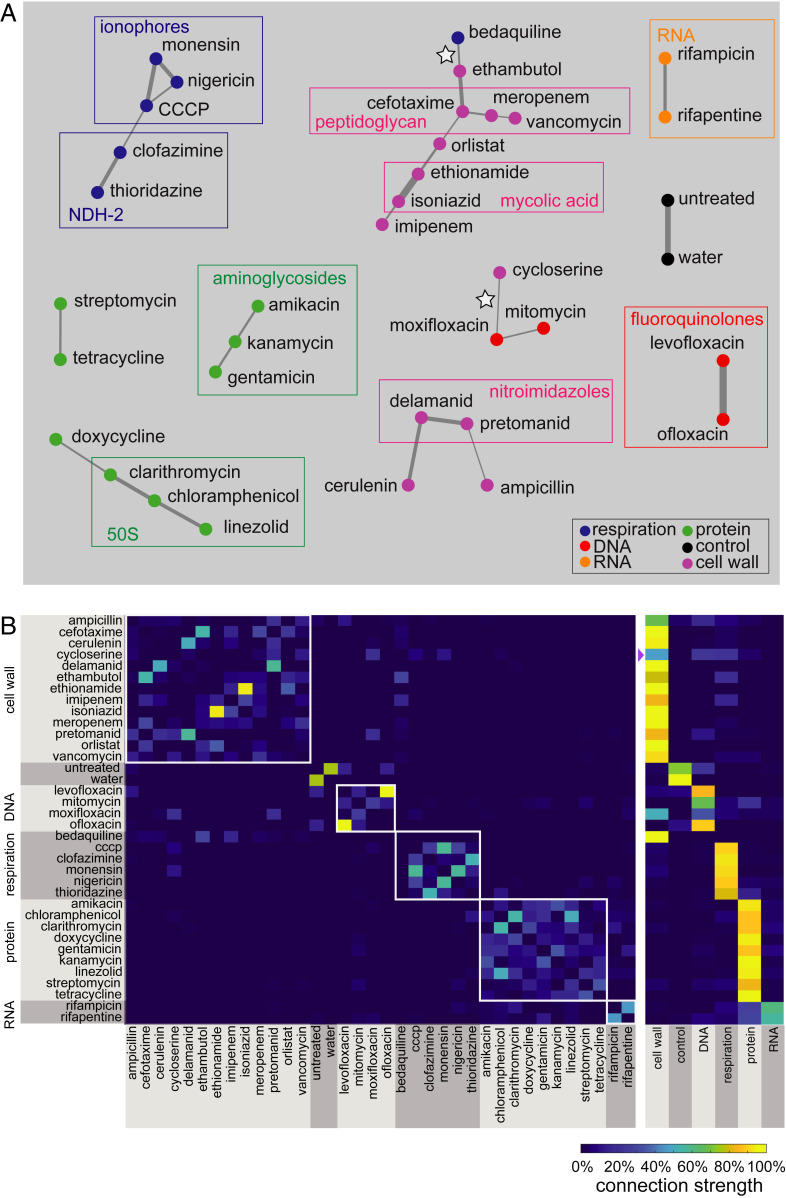
MorphEUS classifies antibacterial compounds by pathway of action. (A) cKNN map of the joint dose profile displaying connections that occur in at least 17% of the classification trials. Drugs within each broad category are represented by nodes of the same color, illustrating whether morphological profiles were similar among drugs acting on the same pathway. Edge thickness indicates the connection frequency for a given connection between two treatment profiles. Rectangles drawn around groups of drugs indicate clustering of drugs that share similar targets within the designated broad category. White stars mark unexpected connections between antibacterials belonging to two different broad categories. (B) cKNN matrix of drug nearest neighbor pairings corresponding to A by specific drugs (Left) and broad categorization (Right). The broad drug target categorizations are indicated to the left of the drug names and on the bottom axis of the heat map on the right. A purple triangle is placed next to the broad categorization for the weakly categorized cell wall acting drug cycloserine.